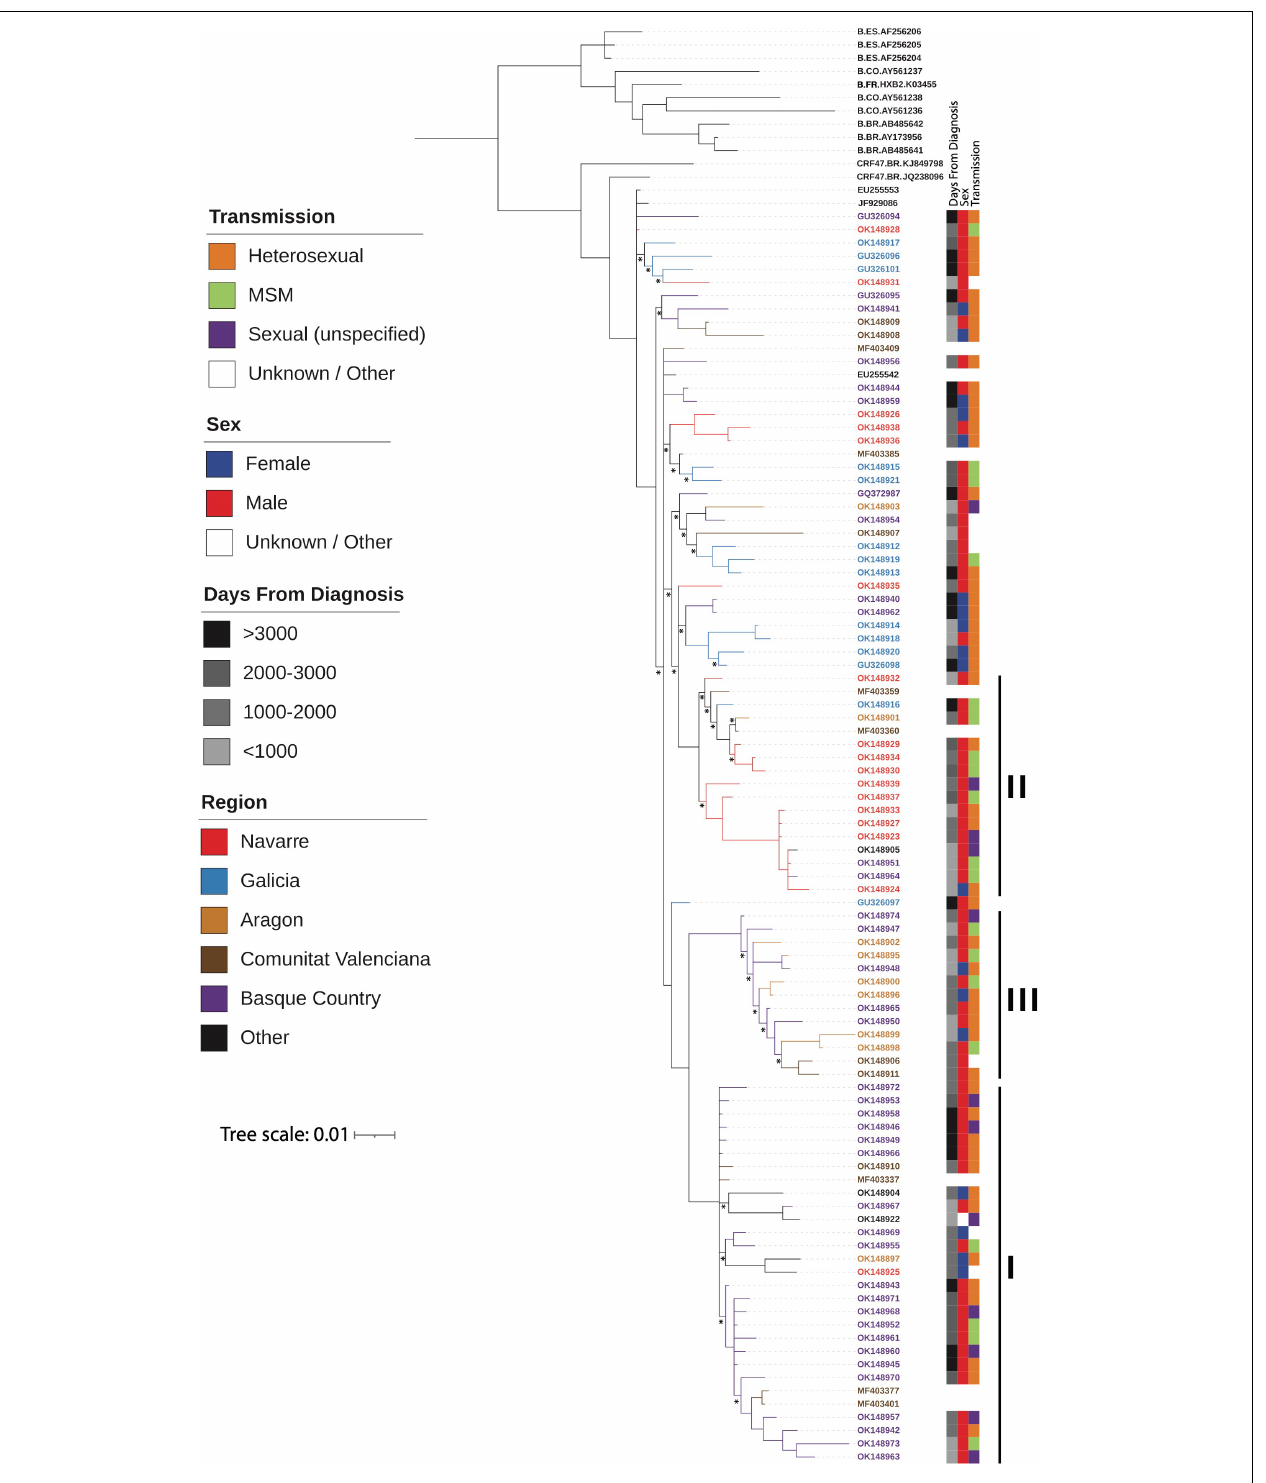
FIGURE 2 | Majority-rule consensus Bayesian (MrBayes) phylogenetic estimate of CRF47_BF sequences from Spain (colored by region) and other CRF47_BF sequences from GenBank, as well as a few additional subtype B sequences from Spain, Brazil, and Colombia plus HXB2, all to serve as an outgroup to the CRF47 sequences. Only clade posterior probabilities < 0.95 are indicated by an *; all other clades showed posterior probabilities ≥ 0.95. Epidemiological data are mapped to the right of the phylogeny, including days from diagnosis, sex, transmission, and geographic region. Branch lengths are drawn proportional to the amount of sequence divergence. Clusters corresponding to the Spanish regions of Basque Country (cluster I), Navarre (cluster II), and Aragon (cluster III) are indicated.